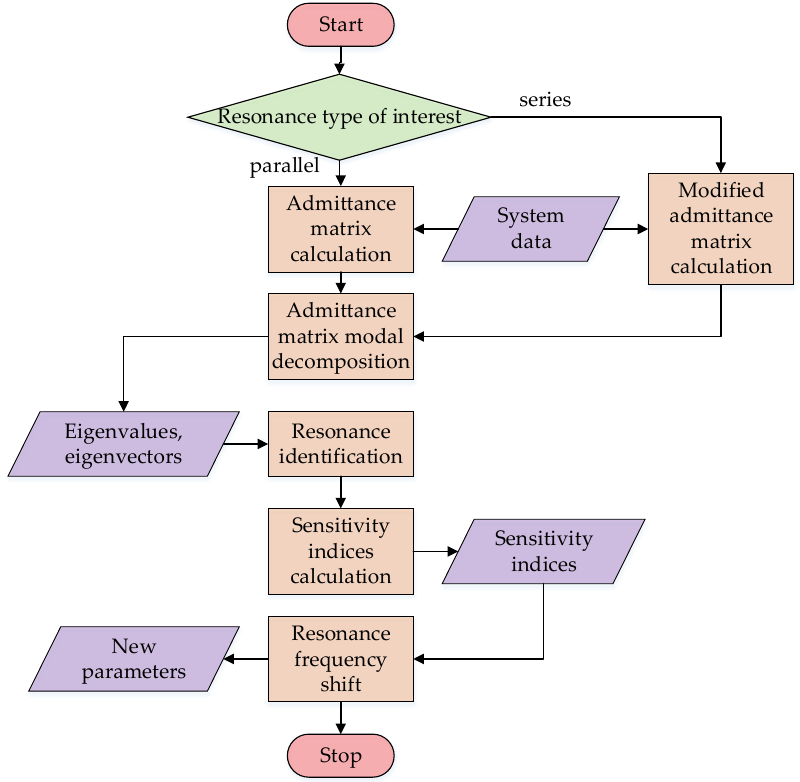
Figure 1. Flowchart of the presented analysis method.